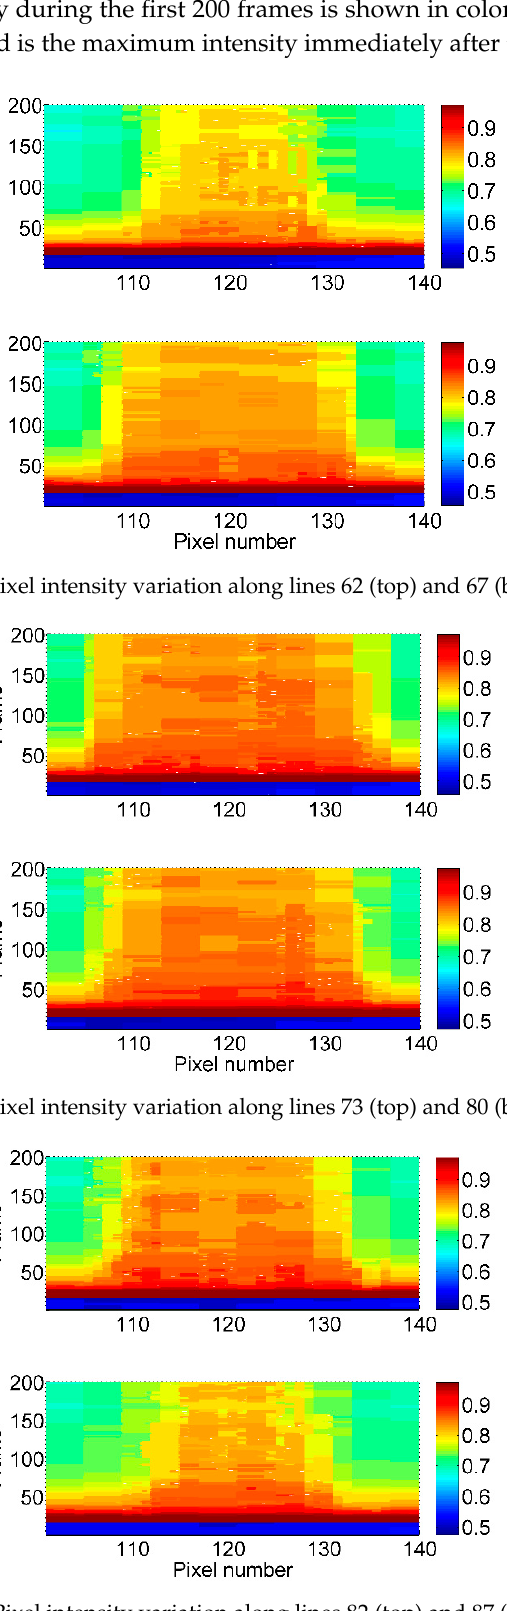
Figure 8. Segments of consecutive frames (broken lines) selected for intensity variation analysis.